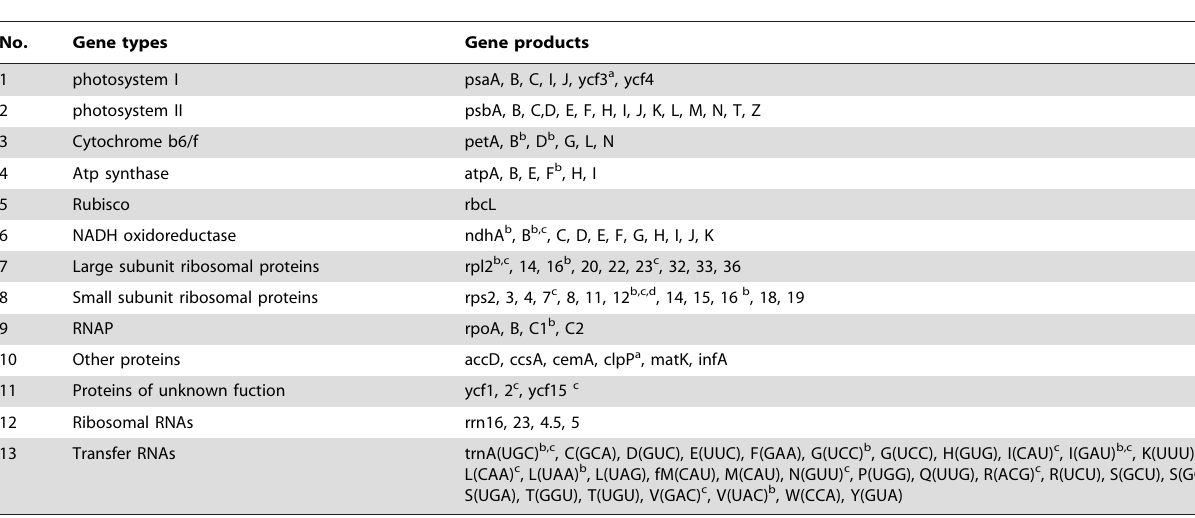
Table 1. Genes present in Artemisia frigida chloroplast